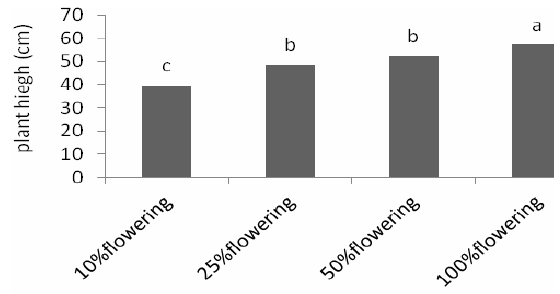
Fig.2. Effect of harvest time on plant height